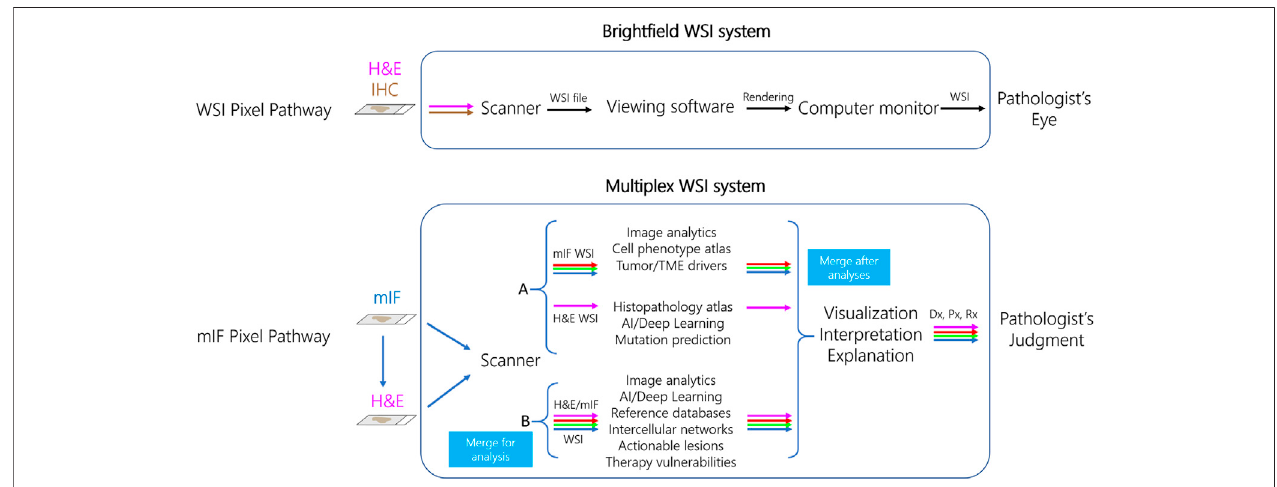
FIGURE 3 | Pixel pathways for diagnostic whole slide imaging (WSI) and multiplex immuno fl uorescence (mIF) systems. In the current FDA WSI system paradigm (top row) , image pixels are traced sequentially through a three-component system that includes bright fi eld scanner, viewing software, and computer monitor to be interpretedbythePathologist.Inaproposedcell-phenotypecentricmIFsystem (bottomrow) ,thepixelpathwayoriginateswithscanningofmIFandthenH&Estainson the same slide, a capability of Ultivue ’ s ISP technology. In model A (top) , mIF and H&E images are separately analyzed using the indicated tools, and then images are merged after analysis. In model B (bottom) , merged mIF and H&E images are subject to a novel data pipeline such as cell-based annotation of H&E sections for analysis by deep learning, allowing earlier de fi nition of each cell ’ s phenotype in the system ’ s pixel pathway. Both models converge so the Pathologist can visualize the mergedimagewithanalyses,followedbyjudgmentofthediagnostic(Dx),prognostic(Px),andpredictive(Rx)explanationsandinterpretationswhenissuingthepatient ’ s diagnostic